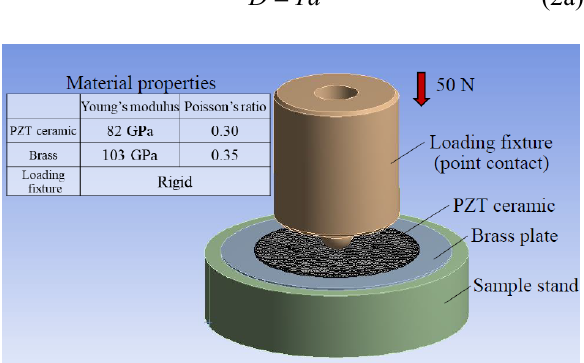
Fig. 3 FE model with material parameters for simulating strain characteristic and electric field in PZT